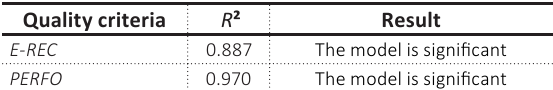
Table 4. R 2 -values Quality criteria